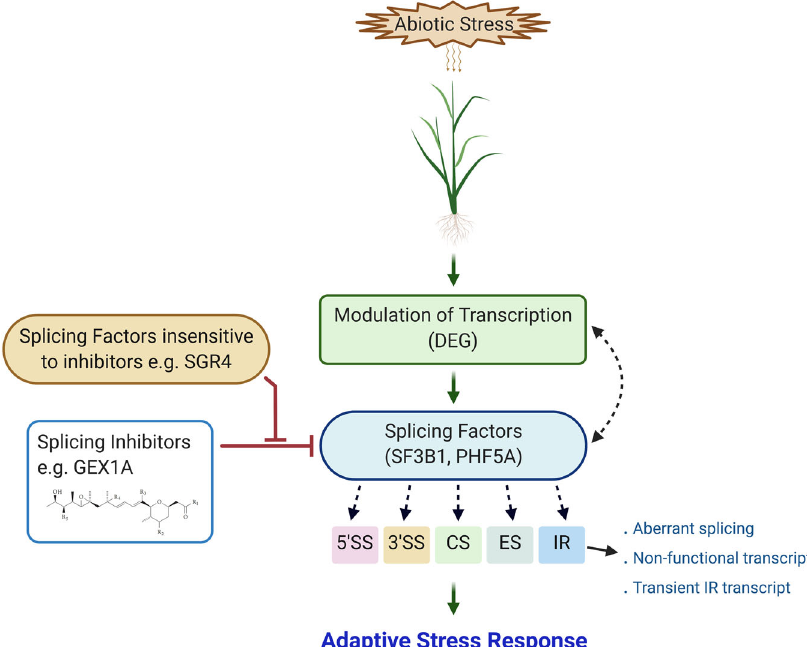
Fig. 9 Model for splicing-mediated adaptive stress responses. Abiotic stress affects global gene expression by reprogramming it at the transcriptional and post-transcriptional levels. Plants perceive stress signals through multiple integrated signaling pathways, which regulate transcription and splicing processes. Transcription factors affect the expression of splicing factors, and in turn splicing factors regulate the splicing patterns of transcription factors. Splicing inhibitors (e.g., GEX1A) inhibit the splicing and activate the stress signaling in plants. The splicing factor protein variants insensitive to GEX1A (e.g., SGR4) impede the inhibitors ’ effects of splicing inhibitors. Stress-modulated transcripts and splice isoforms help plants to cope with abiotic stresses. Arrows indicate activation or repression, and T-bars indicate repression. CS constitutive splicing, ES exon skipping, 5 ′ SS 5 ′ splice site, 3 ′ SS 3 ′ splice site, IR intron